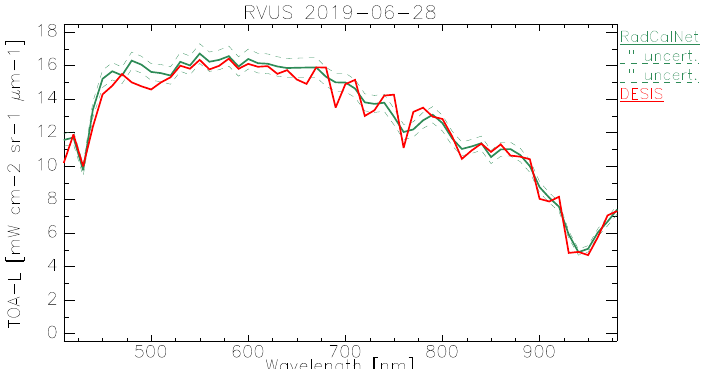
Figure 13. Comparison of RadCalNet TOA-L to DESIS mean TOA-L for RadCalNet location, RVUS, 28 June 2019, resampled to RadCalNet spectral resolution.